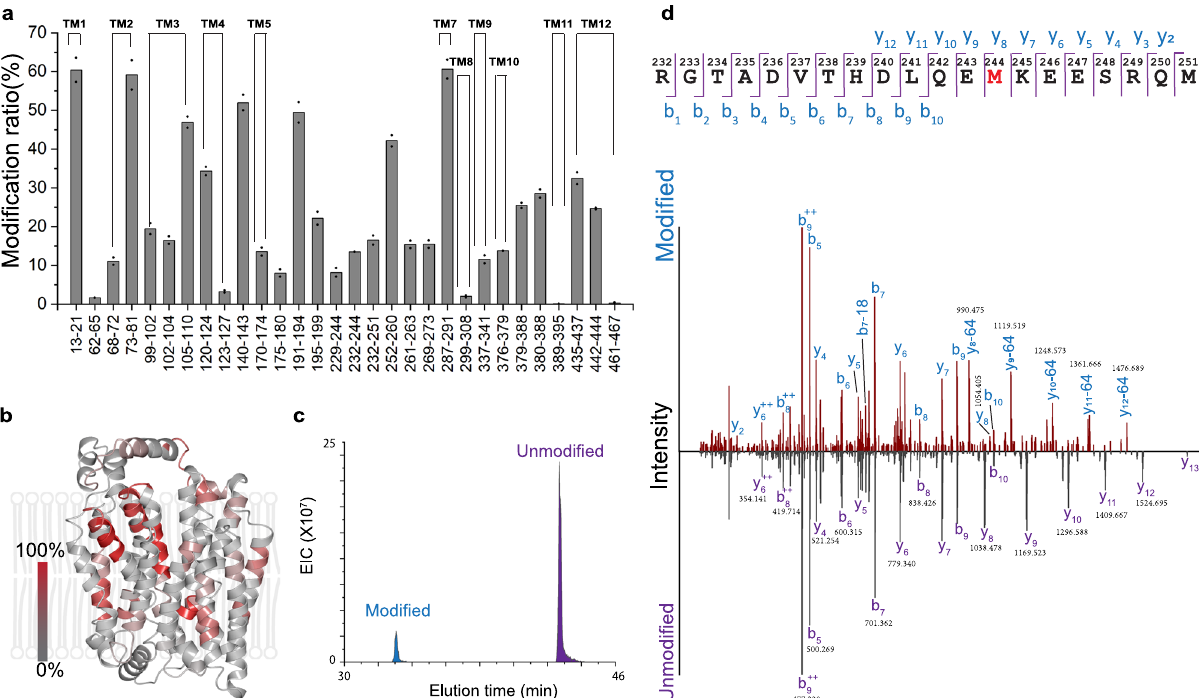
Fig. 3 NanoPOMP of hGLUT1 in liposome. a Modi fi cation ratios at the peptide level. n = 2 independent experiments were repeated, two technical replicates (injections) were conducted for each individual sample. Data are presented as mean values of two biological repeats and dots represent the two corresponding biologically repeats. b Heat map (shaded in red) of the modi fi cation extents at the peptide level. c Extracted ion chromatogram of modi fi ed and unmodi fi ed representative peptide 232 – 251. d CID product-ion (MS 2 ) spectra of modi fi ed and unmodi fi ed peptide 232 – 251. Source data are provided as a Source Data fi